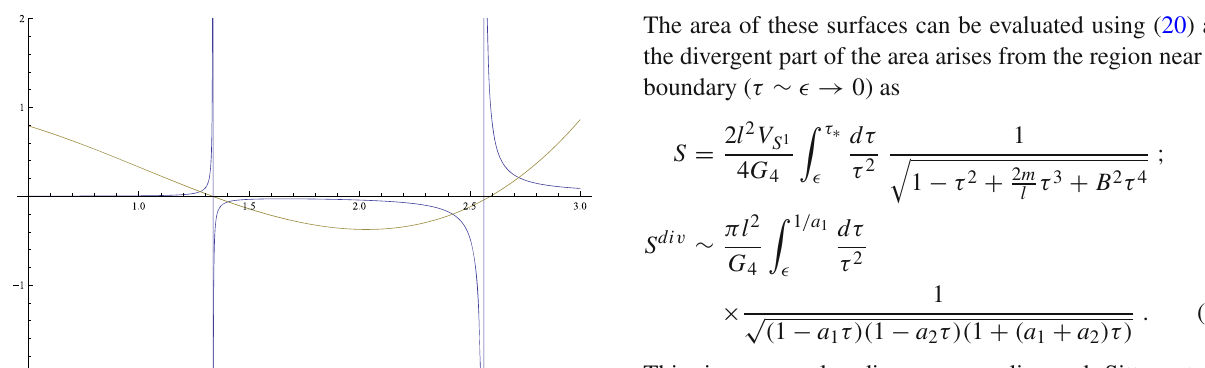
Fig. 2 ˙ w 2 vs τ , for B 2 = 0 . 001, a 1 = 0 . 75 , a 2 ∼ 0 . 39 , m Here B 2 is sufficiently small so that the turning points where ˙ w 2 → ∞ are fairly close to, although not precisely, the horizon values 1 Also plotted is f (τ) for these